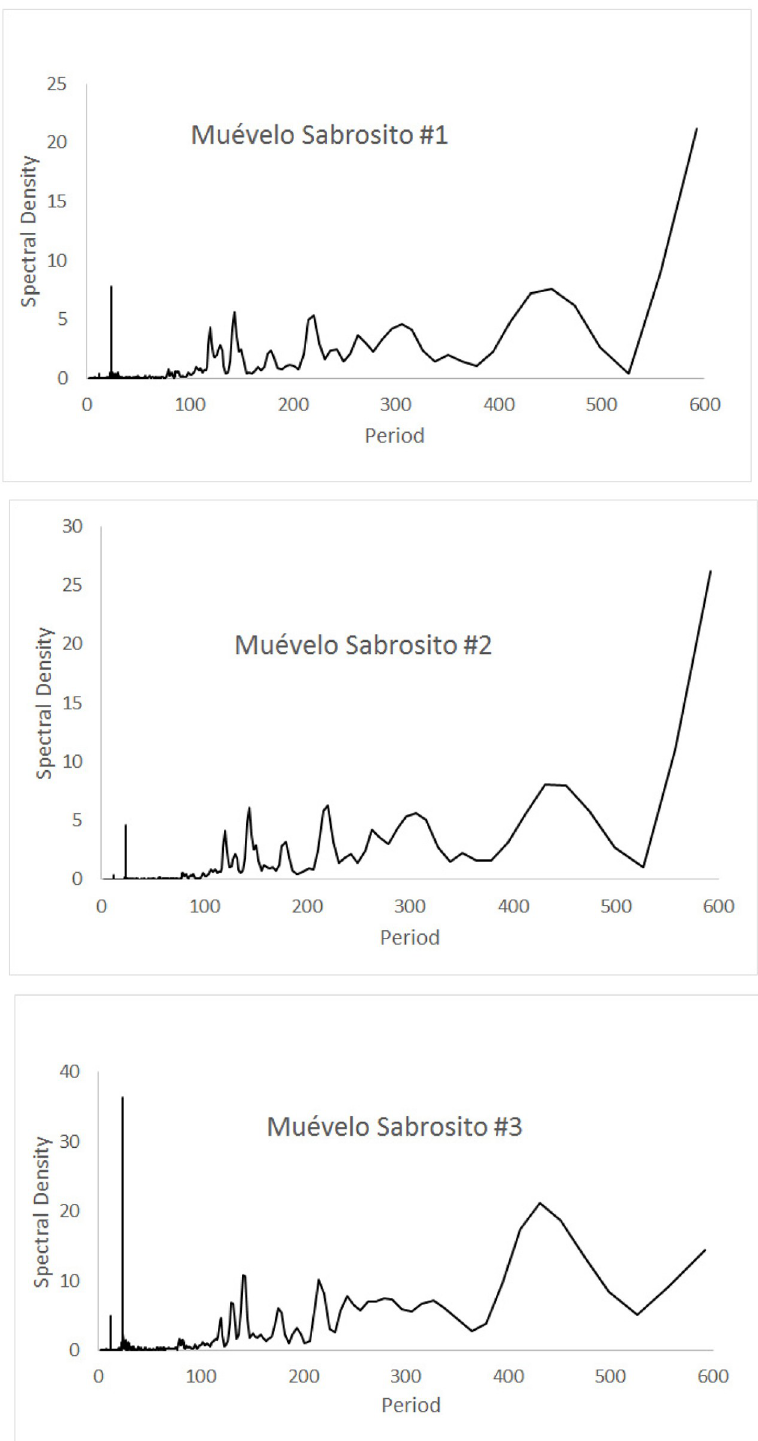
Fig 9. Spectral densities of temperature at the Mue´velo Sabrosito sampling stations. Note that the scale of the y-axis is different for different stations. Period is measured in hours.